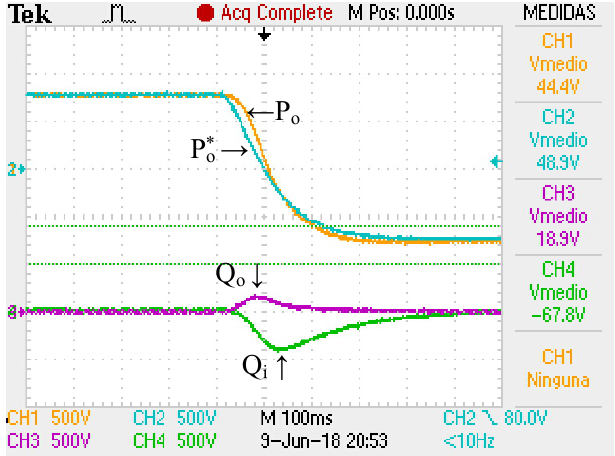
Figure 18. Power tracking and active regulation power flow inversion.